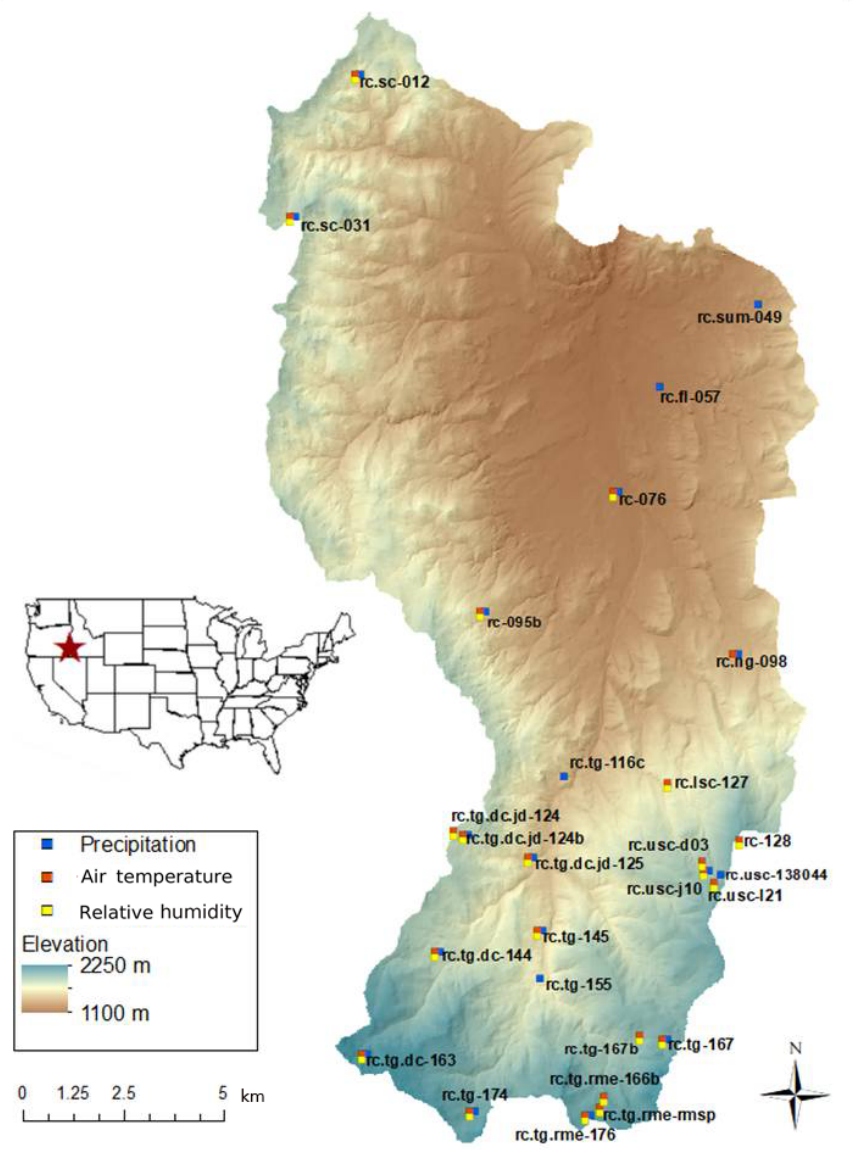
Figure 1. Location map of Reynolds Creek Experimental Watershed showing the elevation (ma.s.l.) and the location of stations used to measure precipitation, air temperature, and relative